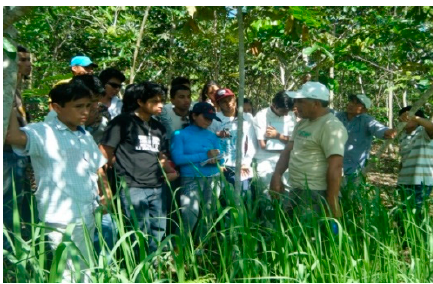
Figure 14. Villagers participating in a field visit and demonstration of practices adopted by BAM.